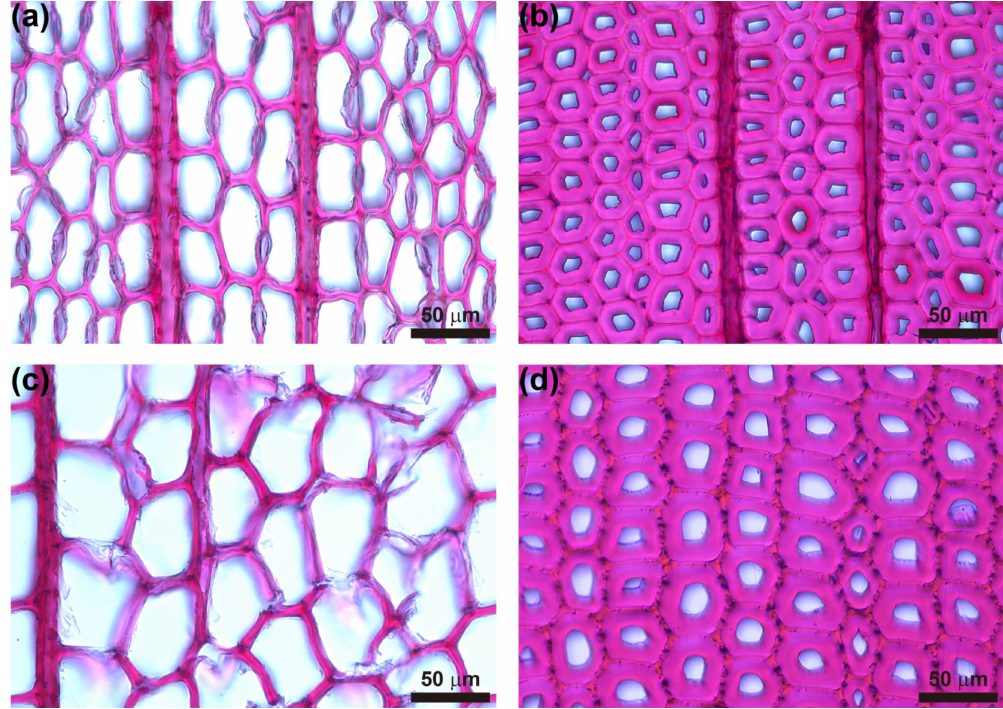
Figure 2. Optical micrographs taken from cross-sections of the heartwood of the recent larch wood (HRW) and the inner part of the ancient architectural wood (IAW). ( a ) The earlywood of HRW. ( b ) The latewood of HRW. ( c ) The earlywood of IAW. ( d ) The latewood of IAW.